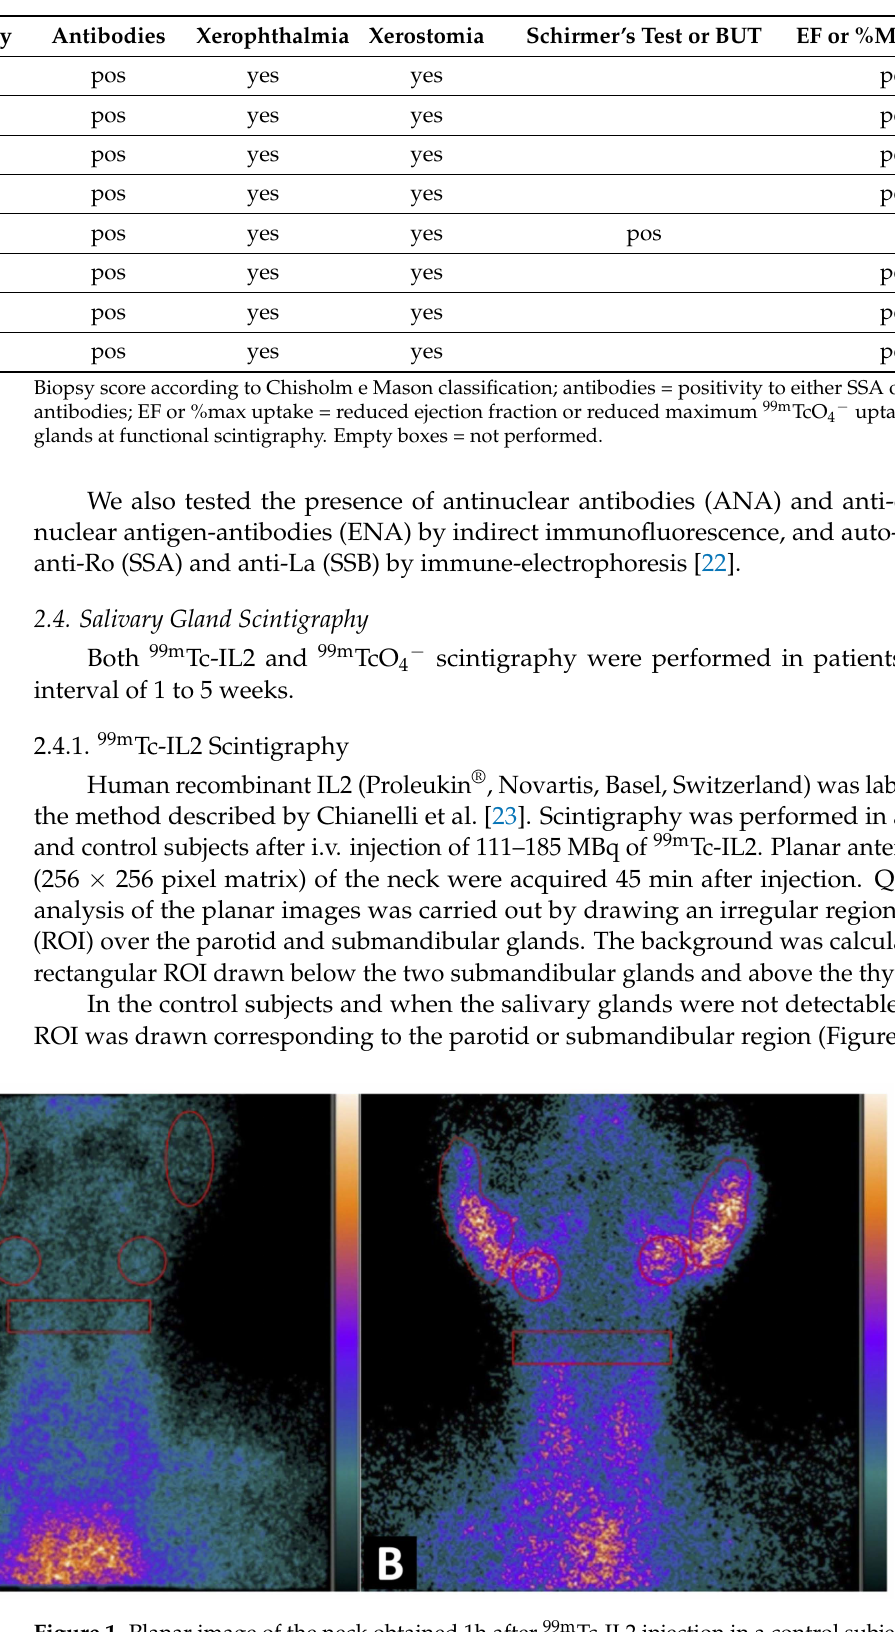
Figure 1. Planar image of the neck obtained 1h after 99m Tc-IL2 injection in a control subject ( A ) and in a patient with Sjögren syndrome at time of diagnosis ( B ). In ( A ) the scan shows no 99m Tc-IL2